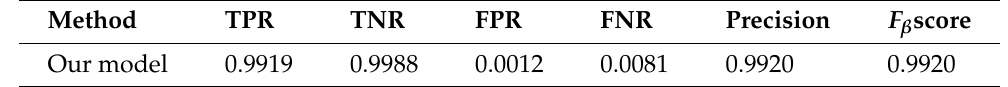
Table 9. The performance of the proposed method on the clinical dataset.